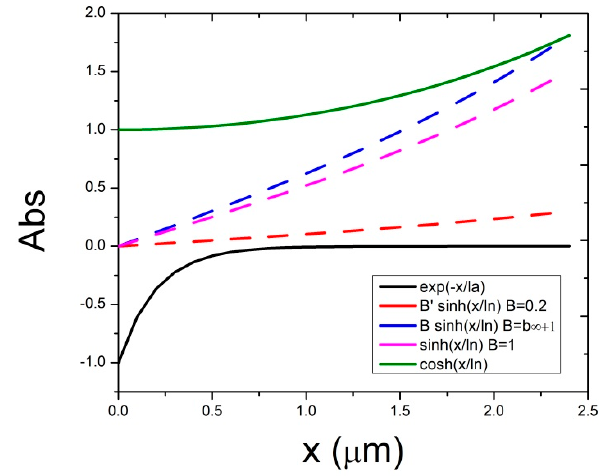
Figure 3. Individual numerical item of the general solution versus x. x is defined as any position in the neutral region.